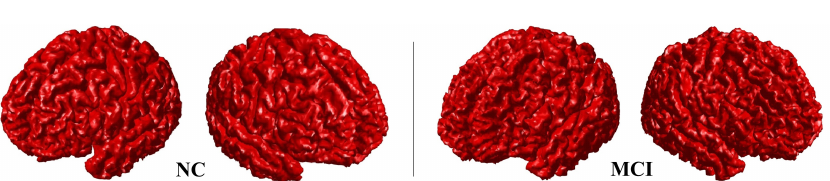
Figure 3. Examples of the marching cubes reconstruction output for normal and mildly cognitively impaired subjects. As shown, although it is not that obvious since it is still the early stage of the disorder, the brain atrophy starts to take place in the MCI case, where this atrophy defines the beginning of losing the neurons and the connections that exist between